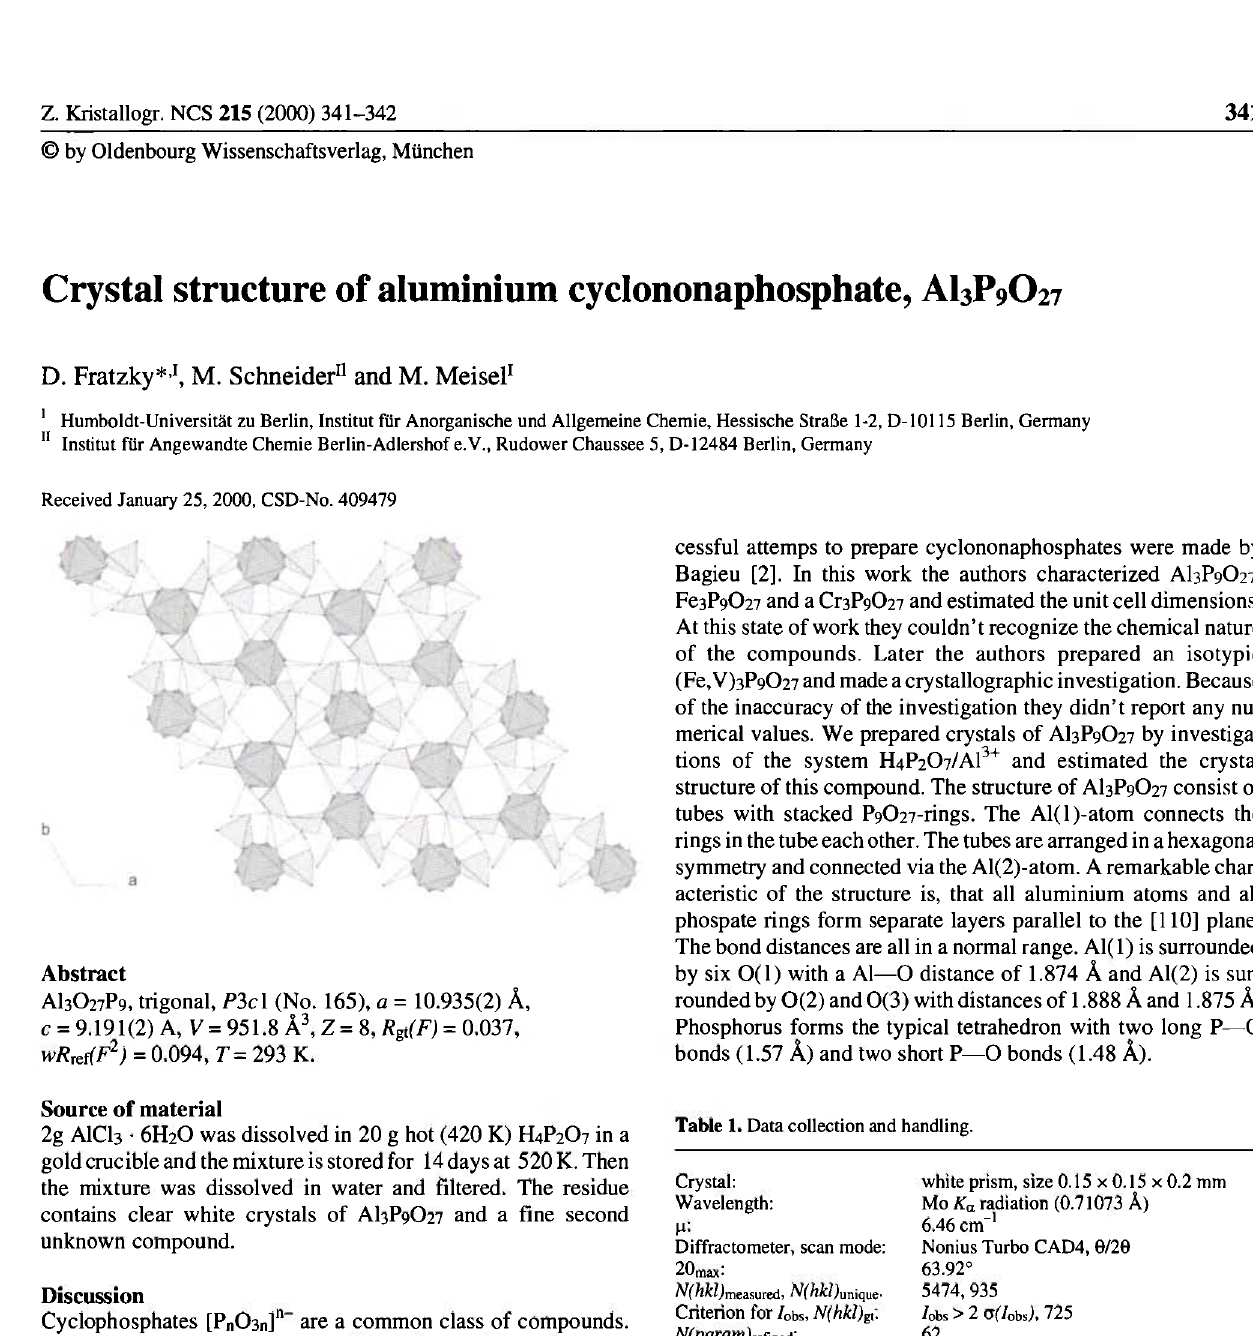
Table 2. Atomic coordinates and displacement parameters (in Ä 2